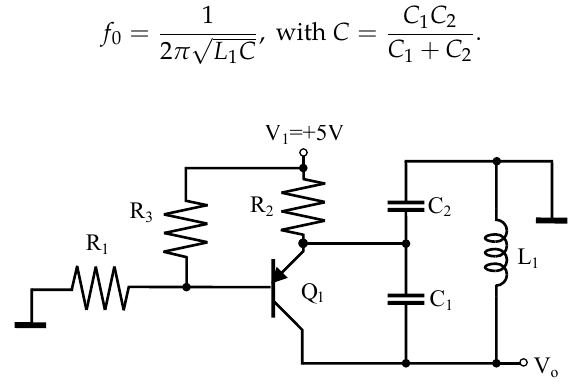
Figure 5. Circuit for the Colpitts oscillator.